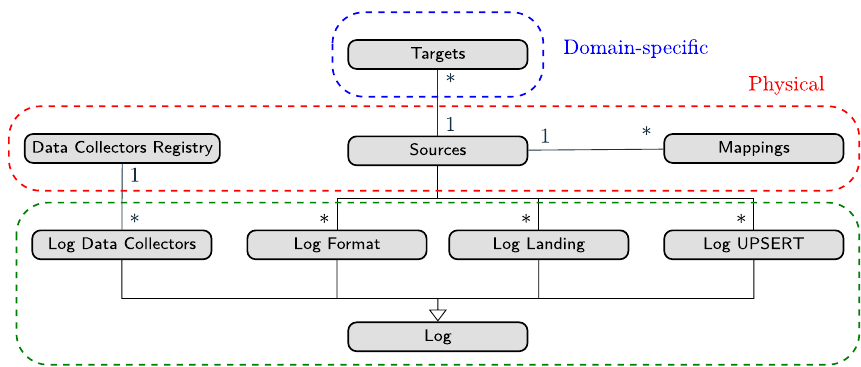
Fig. 8 UML class diagram for the metadata artifacts